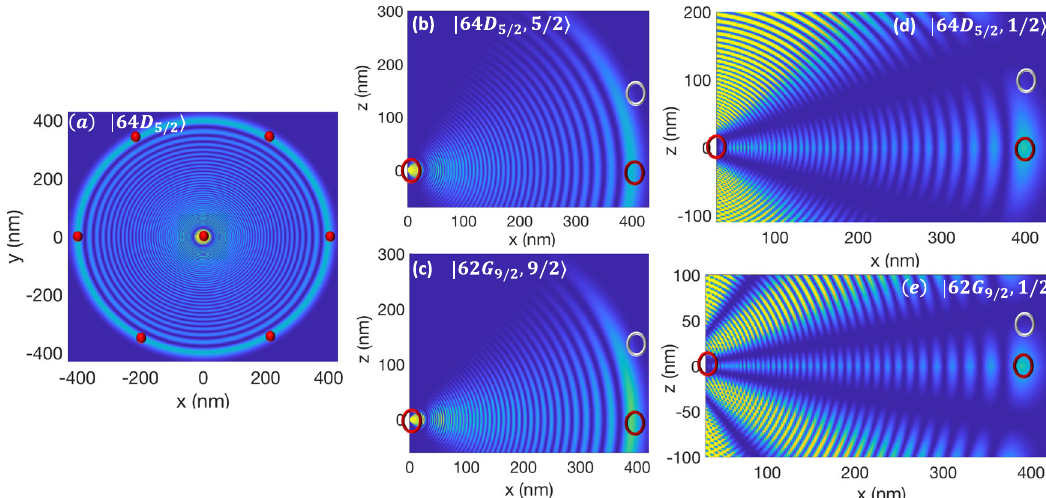
Fig. 5 Controling the Rydberg cloud by adjusting the azimuthal and magnetic quantum numbers. The cloud geometry are depicted with respect to lattice sites presented by red/white ovals corresponding to the 0 j i / 1 j i qubit states. a Shining the laser perpendicular to the lattice plane (that de fi nes the quantization axis along z ), the symmetry of the wave function in the lattice plane results in a uniform interaction with all plaquette qubits. b , c Exciting (cid:1) (cid:3) (cid:1) nL j ; m j ¼ j would con fi ne the cloud close to the lattice plane providing larger interaction. The centrifugal force at higher orbital angular momentum numbers, pushes the electron away from the core towards the neighboring ground-state atoms, enhancing the interaction. d , e Exciting nL j ; m j ¼ 1 = 2 increases the number of the angular nodes, allowing a signi fi cant reduction of the qubit-dependent lattice shift with the price of reducing the interaction strength. Table 1 Rydberg-Fermi gate operation with high orbital angular momentum Rydberg states.